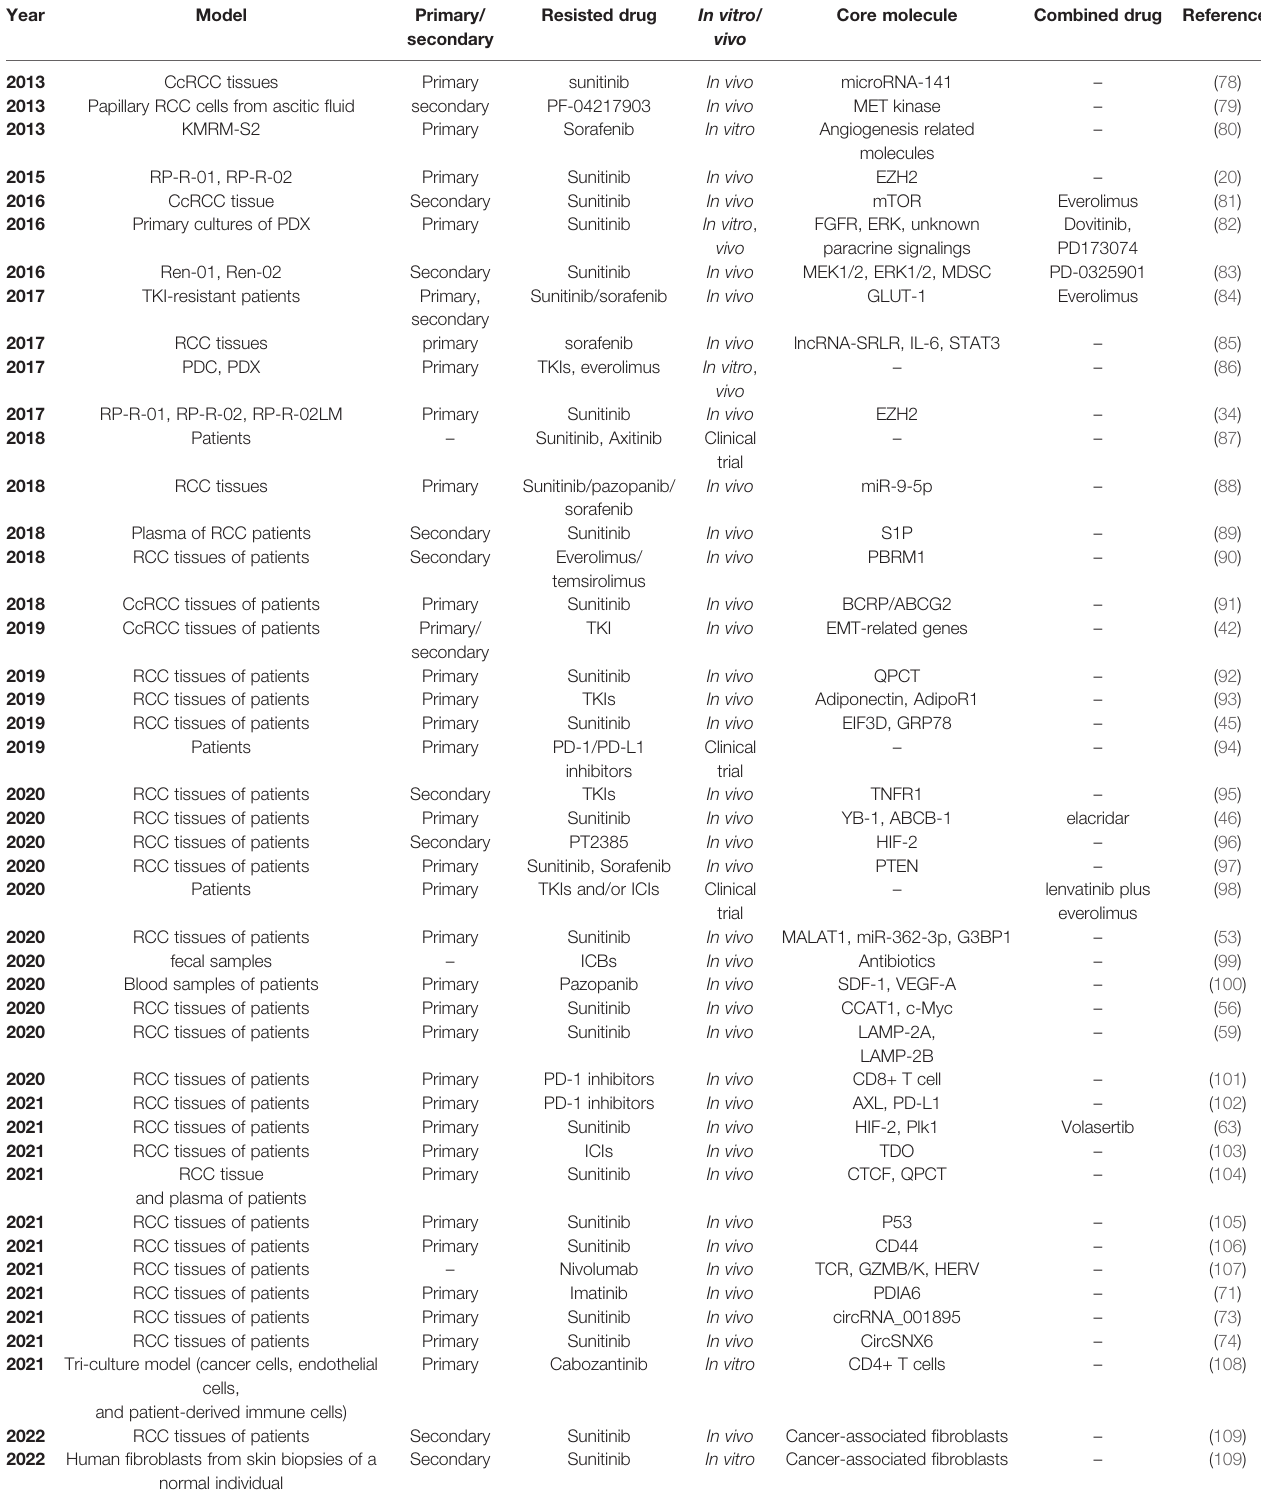
TABLE 2 | Studies on RCC drug resistance using patient-derived in vitro and in vivo